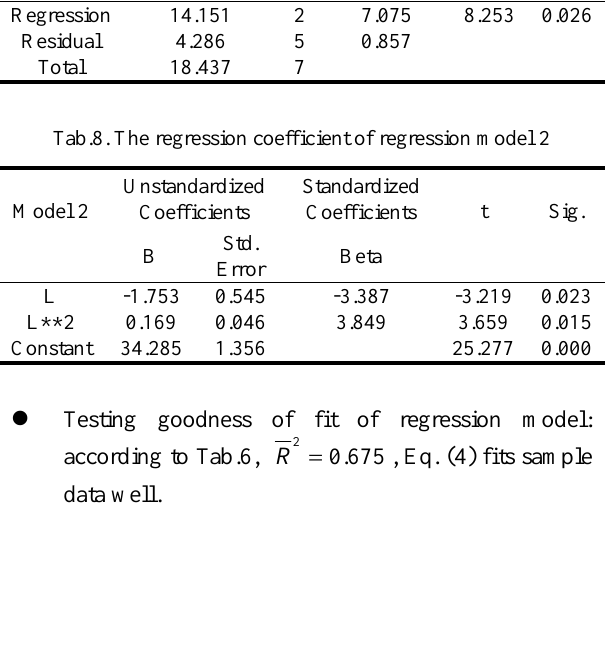
Tab.10. The determinant coefficient of regression model 3